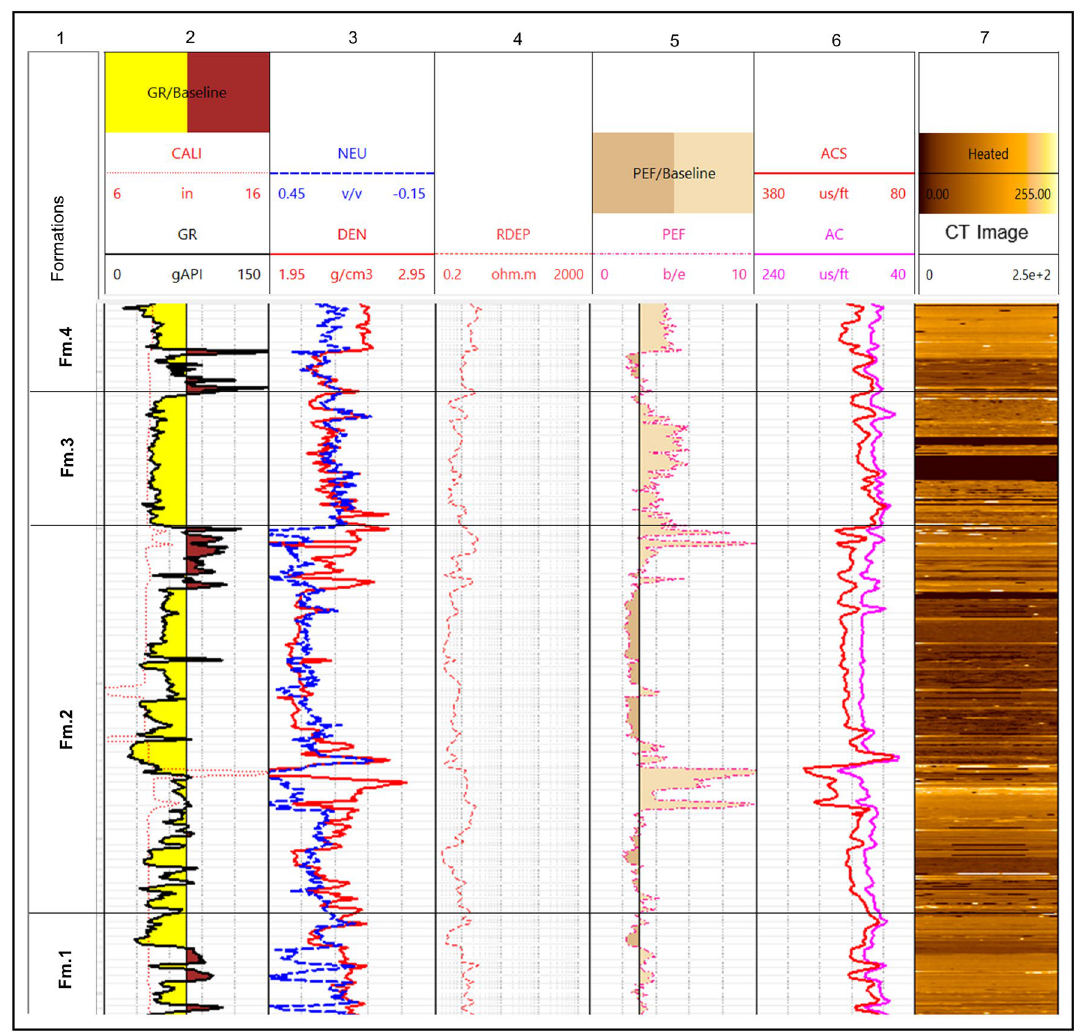
tivity (RDEP), track 5: Photoelectric factor (PEF), track 6: Compres- sional wave slowness (AC) and shear wave slowness (ACS), track 7: 2D cross section of whole core CT